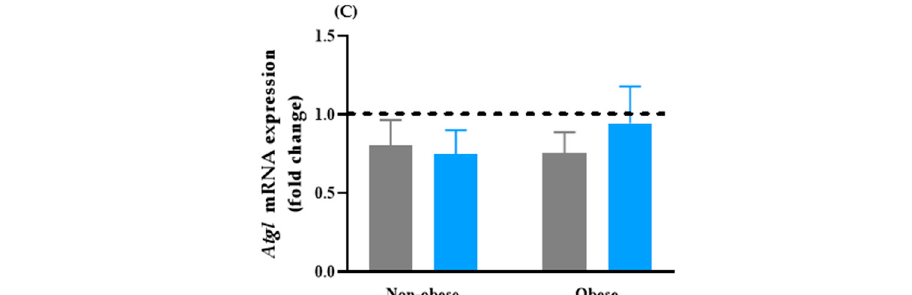
Figure 3. Effects of non-obese and obese breast milk with high and low n-6:n-3 PUFA ratios on the mRNA expression of lipolytic genes in 3T3-L1 adipocytes. Preadipocytes were differentiated for 8 days in the presence or absence of breast milk (BM) whey. Data represent the mRNA expression of: ( A ) perilipin ( Plin1 ), ( B ) adipose triglyceride lipase ( Atgl ), and ( C ) hormone-sensitive lipase ( Hsl ). The gene expression was normalized with RPLP0 as the housekeeping gene. Values for the control cells (no breastmilk treatment) were set to 1.0 and are represented by the dashed line. Values are expressed as mean ± SD, n = 3. Data were analyzed using two-way ANOVA to determine the effect of treatment, and a Bonferroni post hoc test was used to determine differences when there was a significant interaction. p < 0.05 was considered significant. Q—quartile.